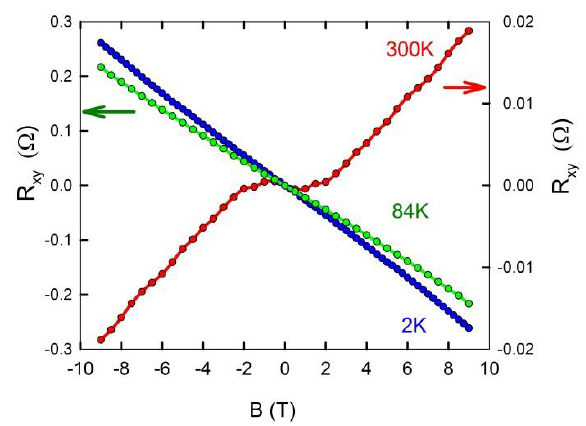
Fig. 7. Magnetic field dependence of Hall resistance for SiO x /EuSi 2 /SrSi 2 /Si(001) structure measured at three temperatures: 2 K (blue), 84 K (green) and 300 K (red). In